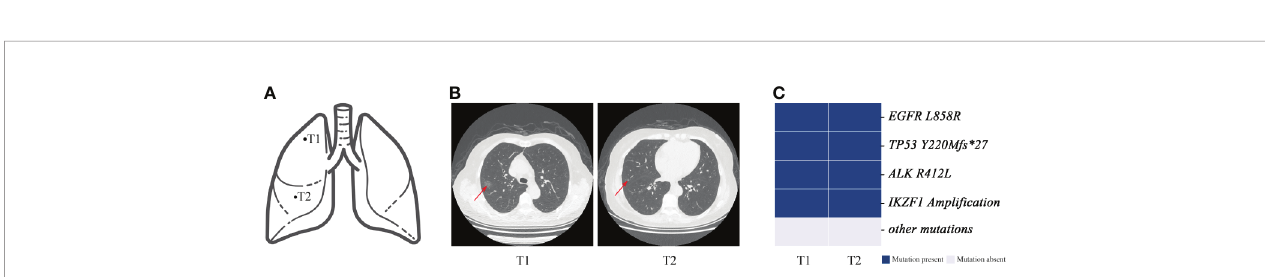
FIGURE 6 | Proposed algorithm for classifying multiple primary lung cancers based on molecular criteria. IM, intrapulmonary metastasis; MPLC, multiple primary lung cancer.